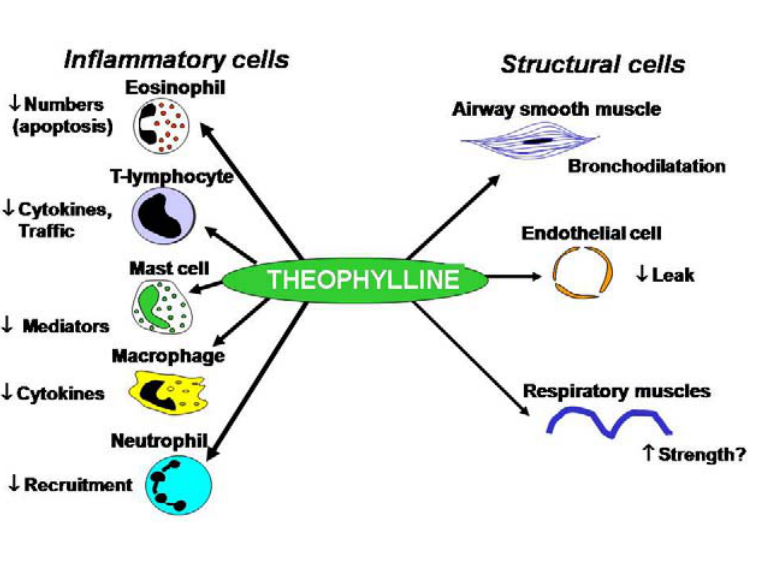
Figure 3. Multiple cellular effects of